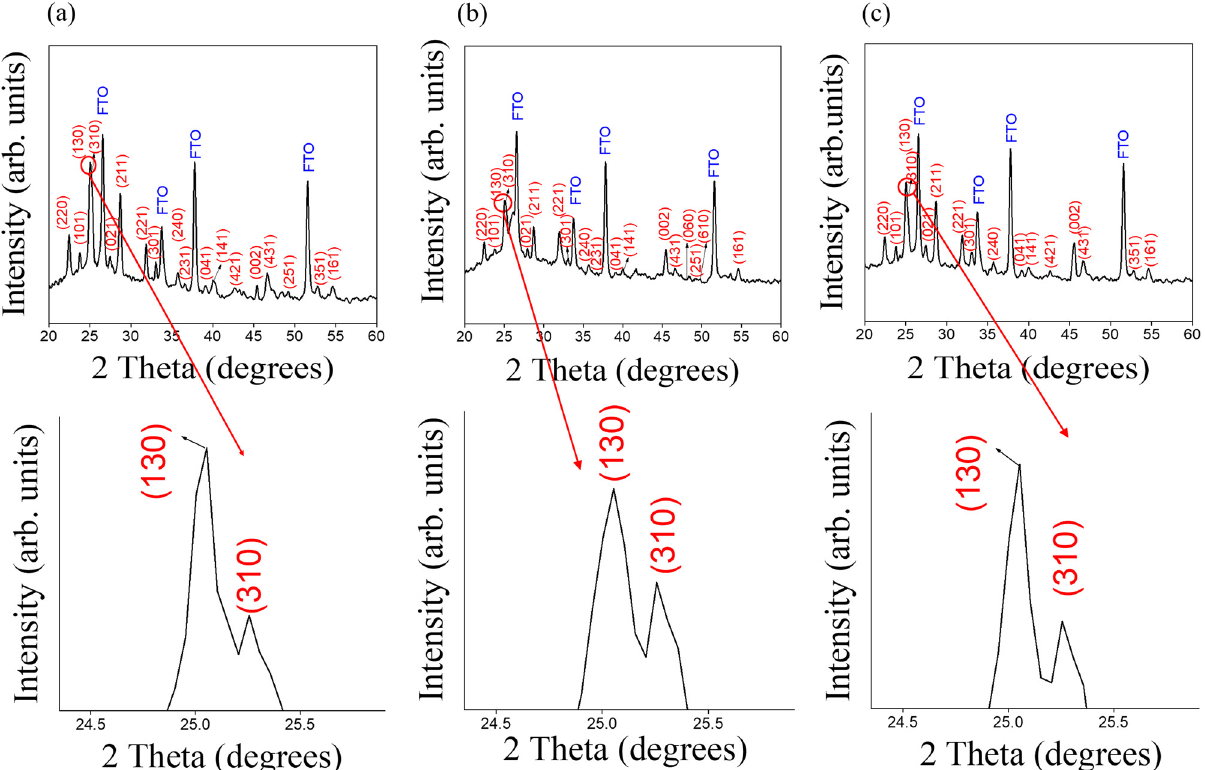
Figure 2: XRD patterns of Bi 2 S 3 crystals formed with Bi 2 O 3 thin - fi lm templates from various vulcanization processes: ( a ) 0.01 M TU, ( b ) 0.03 M TU, and ( c ) 0.1 M TU. The enlarged XRD plots with 2 θ at around 25 o are also shown for